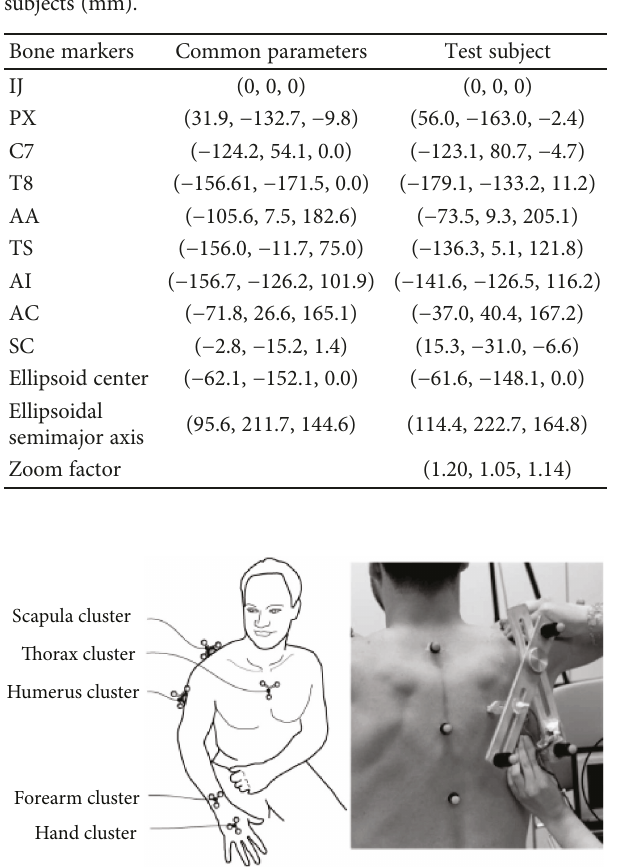
Figure 4: The bony landmarks and local coordinate systems de fi ned in ISB. Table 3: The skeletal feature size parameters of the experimental subjects (mm).